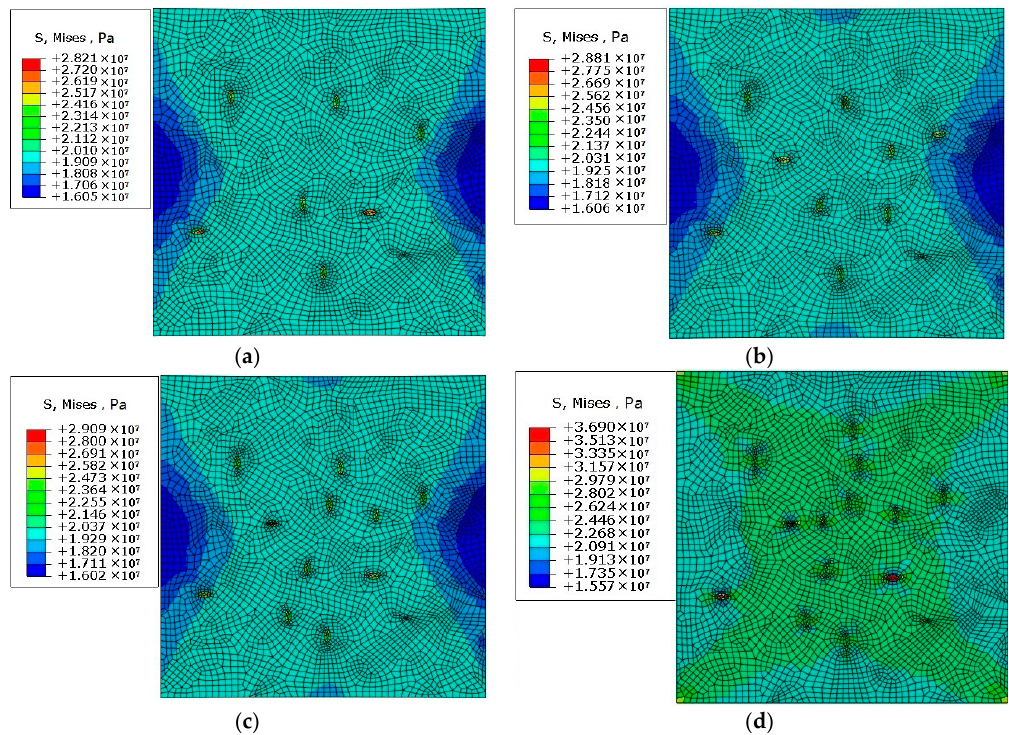
Figure 19. Stress distribution diagram of a polycrystalline model with different impurity percentages of ( a ) 0.44%, ( b ) 0.57%, ( c ) 0.70%, and ( d ) 0.82%.